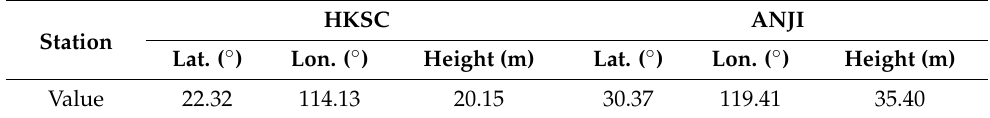
Table 6. Location and height of the selected stations.